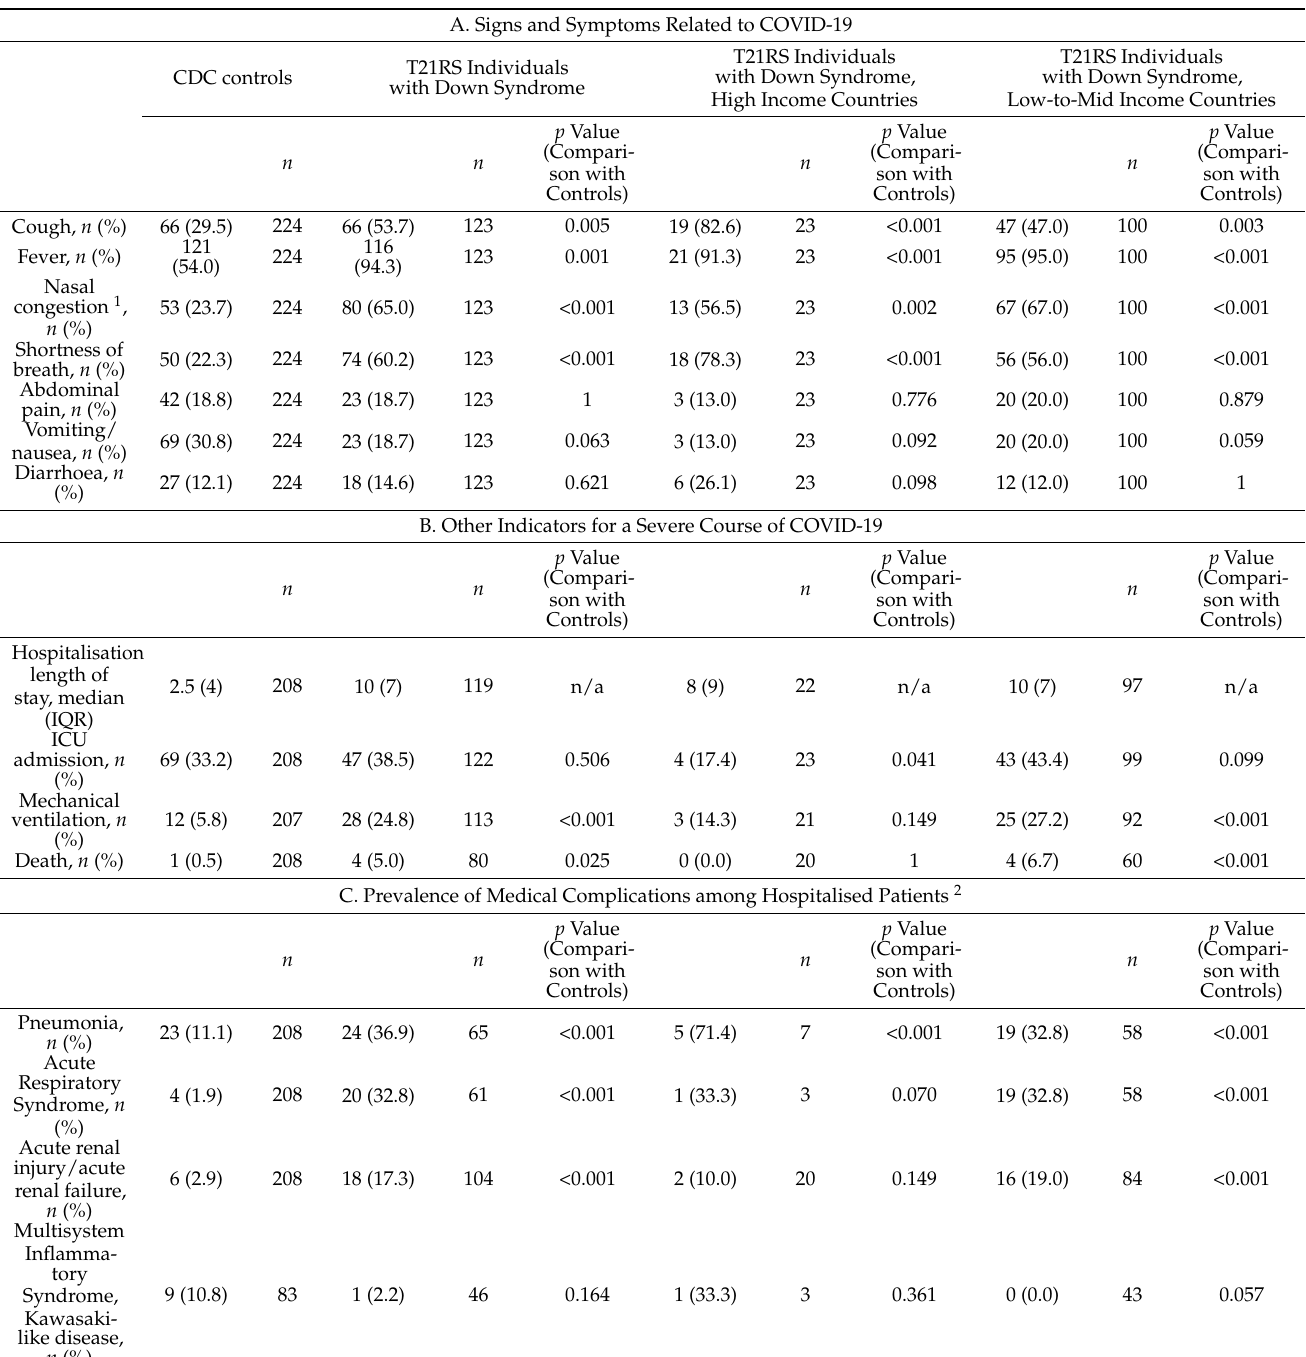
Table 2. Severity of COVID-19 among hospitalised individuals with and without DS stratified by high-income and low to middle-income